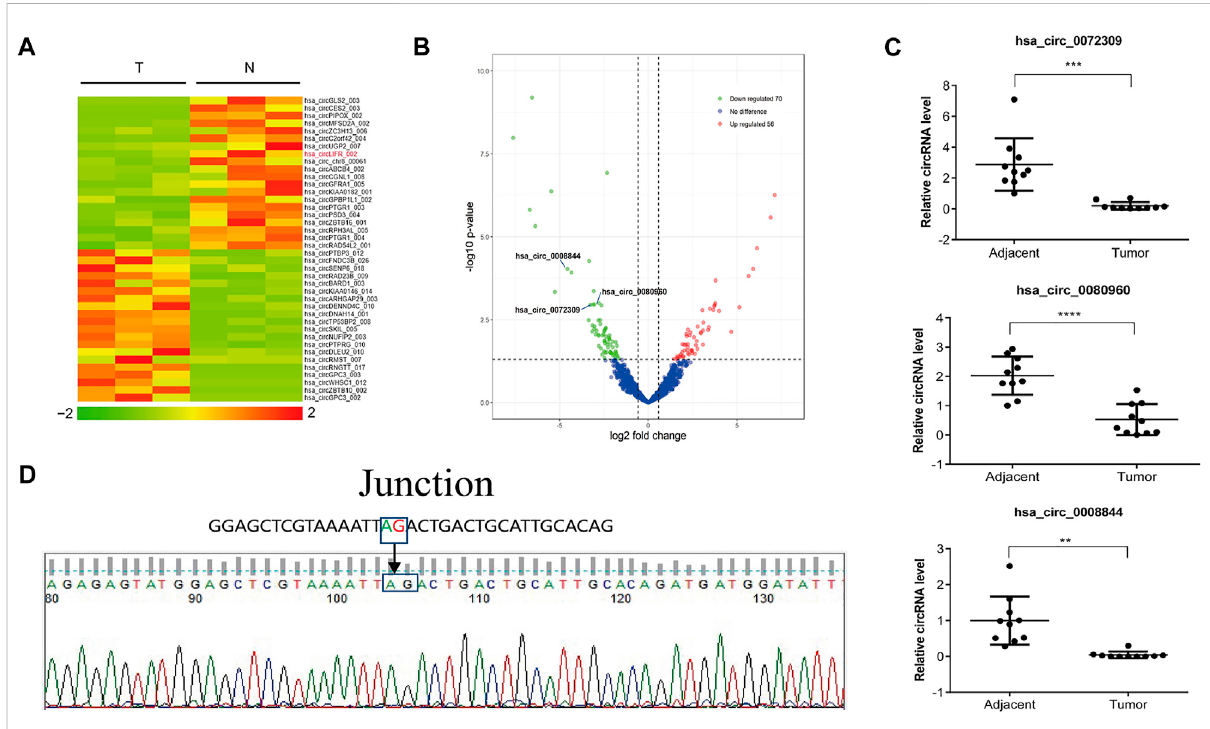
FIGURE 1 Identi fi cation of circLIFR by RNA-seq in liver cancer tissues. (A) Heat map of circRNA expression fold-change. Red indicates a higher fold- change; (B) Volcano plots of differentially expressed circRNAs in the three pairs of matched liver cancer tissues and adjacent normal tissues; (C) Expression levels of circRNA in paired HCC and adjacent tissues collected from 10 HCC patients were measured by qRT-PCR assay; (D) Sanger sequencing of circLIFR.